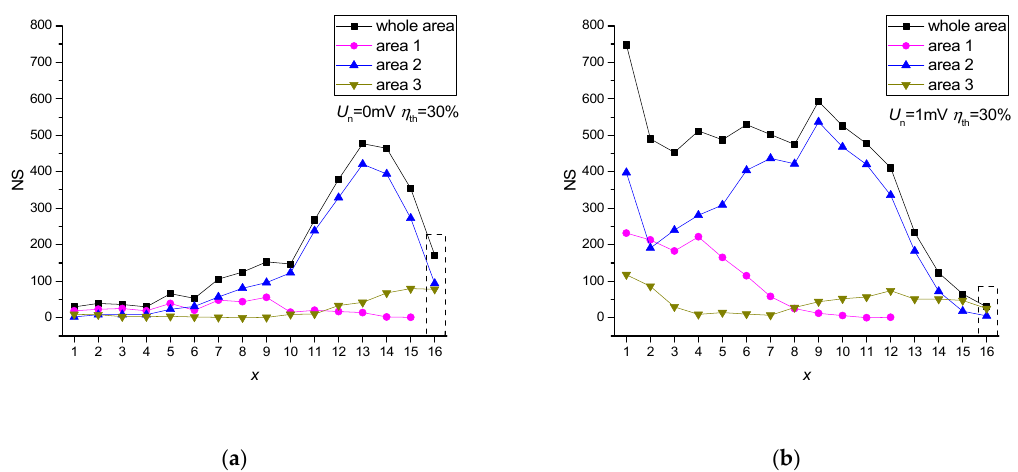
Figure 15. Distribution of the number of NS solutions to the “ x of x ” problem, for different regions of the I ON - I OFF current space without accounting for chimeric synchronization at ( a ) U n = 0 V and ( b ) U n = 1 mV. The numbers of the regions correspond to Figure 11. The dotted line highlights the area of the solutions to the “16 of 16” problem.